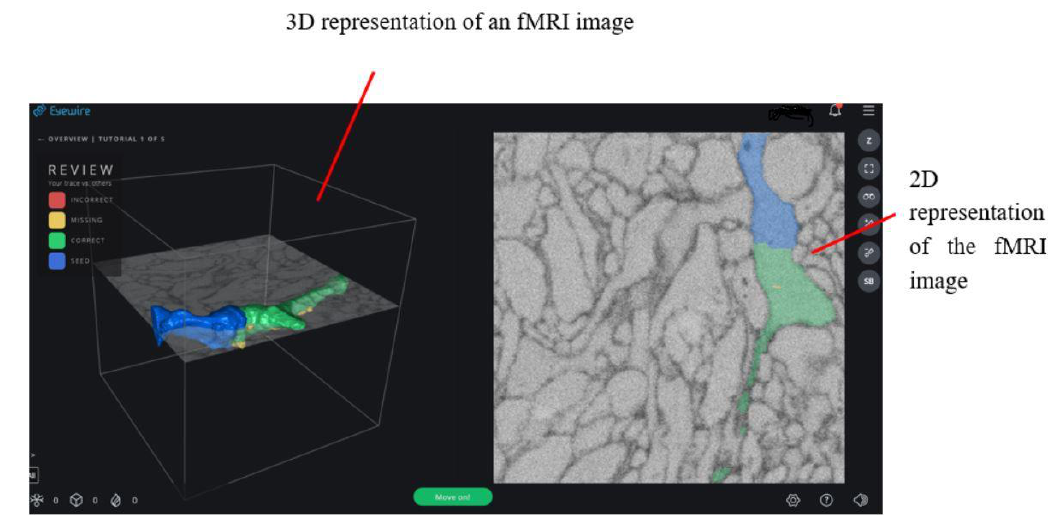
Figure 5. Eyewire interface (https://eyewire.org/explore) .